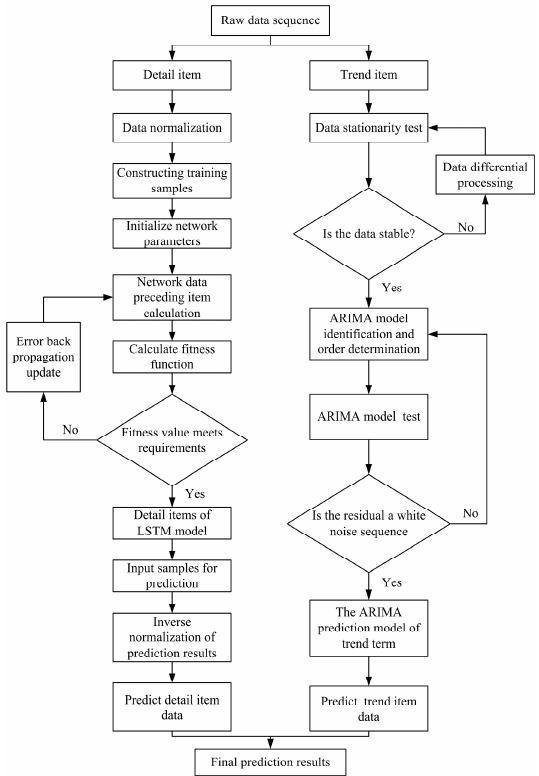
Figure 3. Working flow of ARIMA–LSTM models.